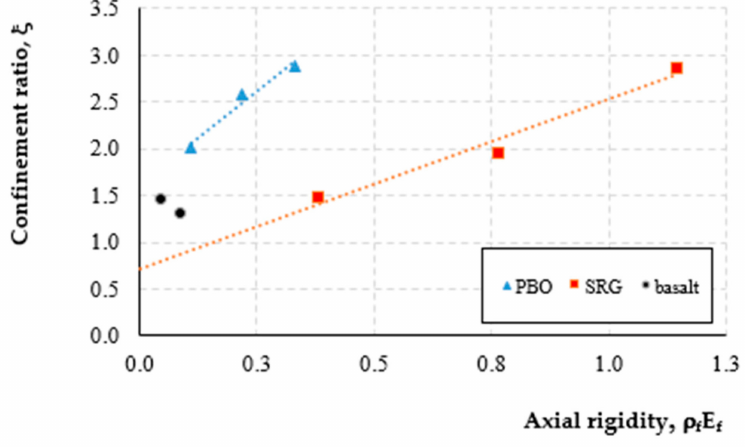
Figure 13. Confinement ratio versus axial rigidity for confined